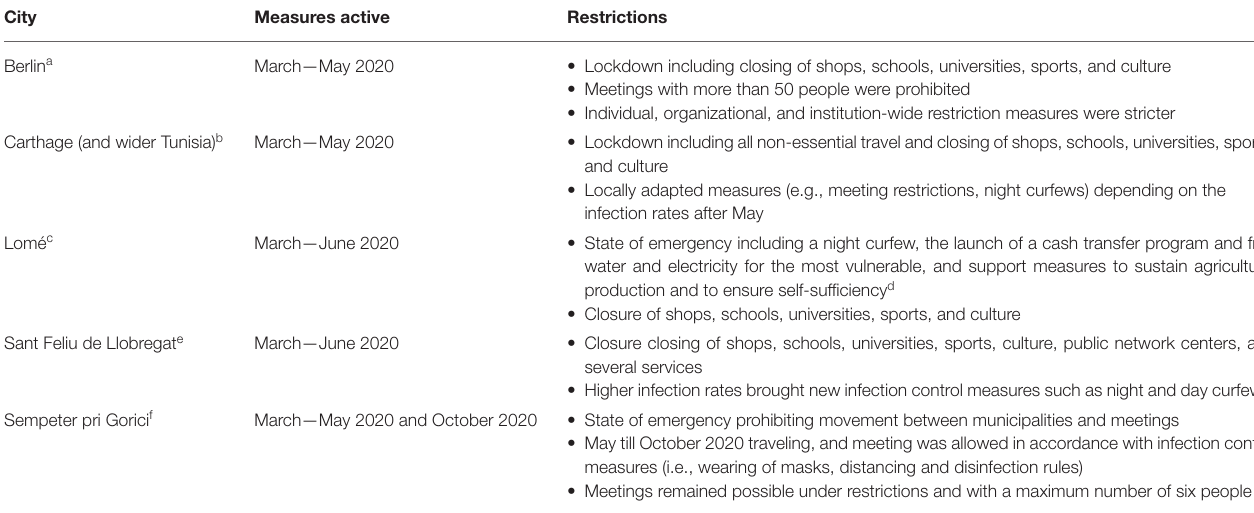
TABLE 2 | COVID-19